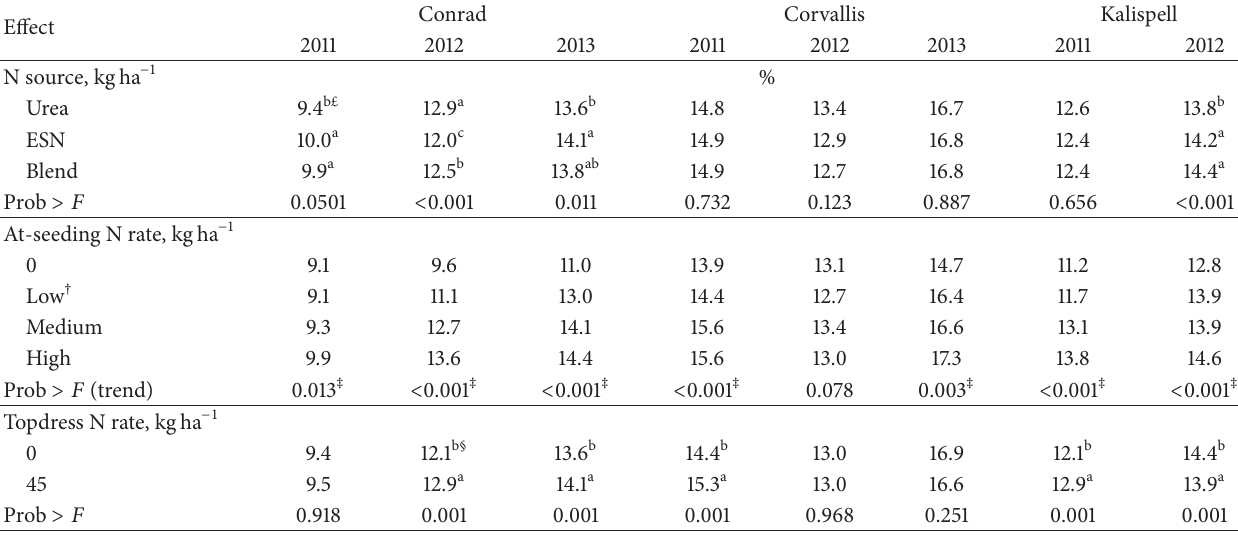
Table 4: Effect of at N source and preplant and topdress N rate on spring wheat grain protein Conrad, Corvallis and Kalispell, 2011–2013 growing seasons.